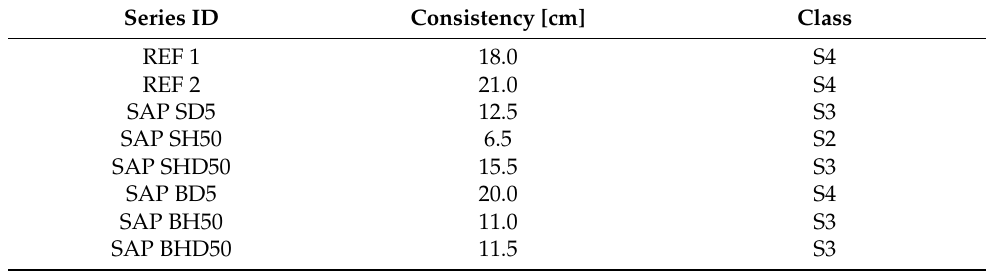
Table 6. Consistency of tested concrete series measured by the slump test